Question: Write a single sentence explaining what this figure depicts.
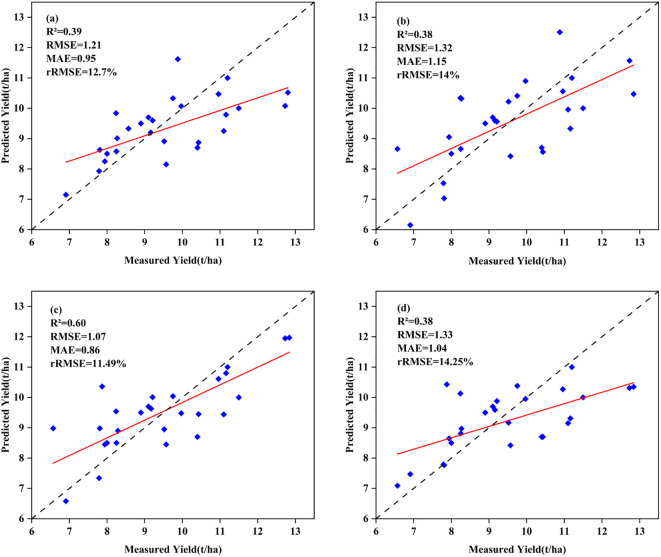
Answer: Scatterplots of measured versus model-predicted maize yields. (A) Extra Trees (ET); (B) Gradient Boosting Decision Trees (GBDT); (C) Histogram-Based Gradient Boosting Decision Tree (HGBDT); (D) Random Forest (RF).